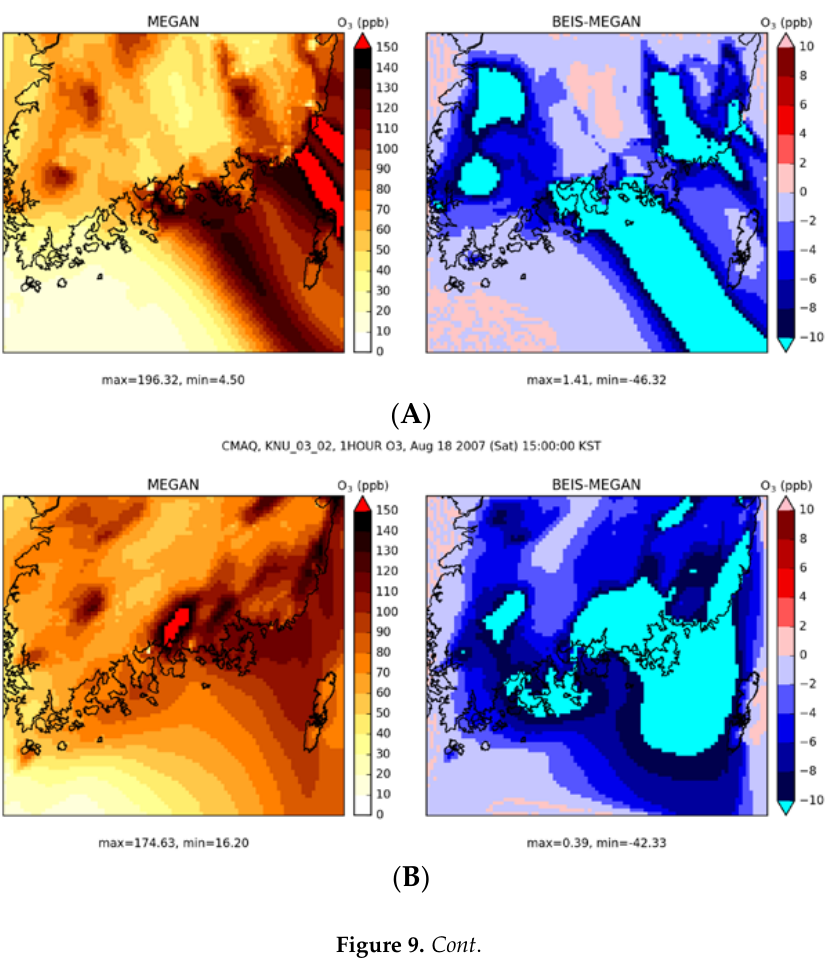
Figure 8. MDA1O3 estimated with CMAQ-MEGAN ( left ) and differences between CMAQ-MEGAN and CMAQ-BEIS3 ( right ): ( A ) 17 August; ( B ) 18 August; ( C ) 24 August; and ( D ) 25 August